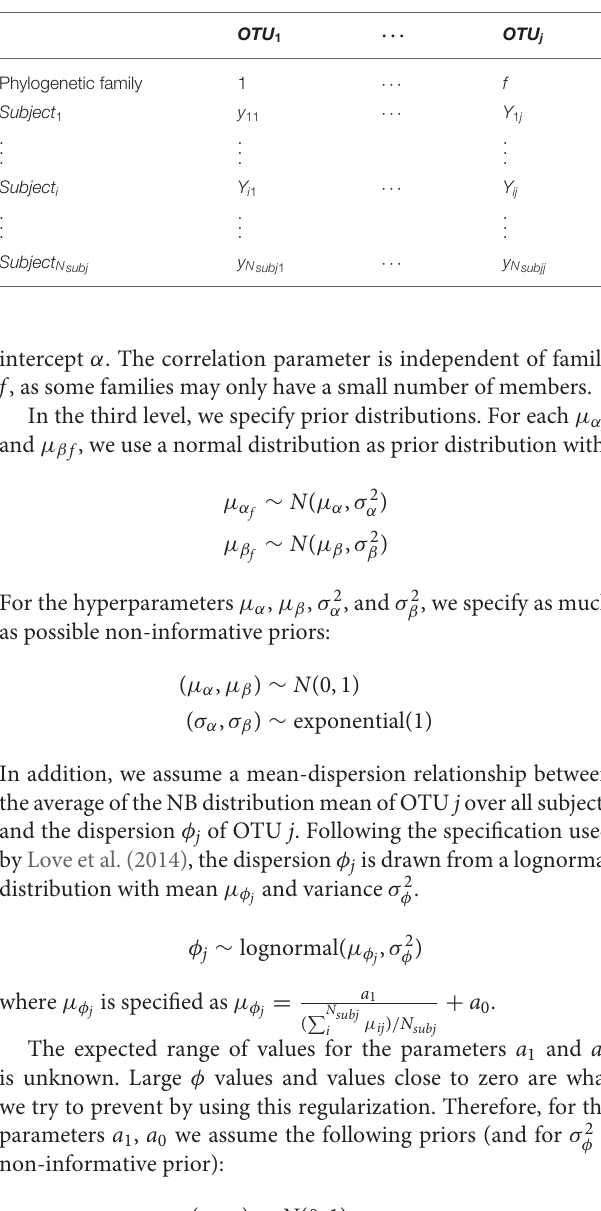
TABLE 1 | The data structure of the microbiome